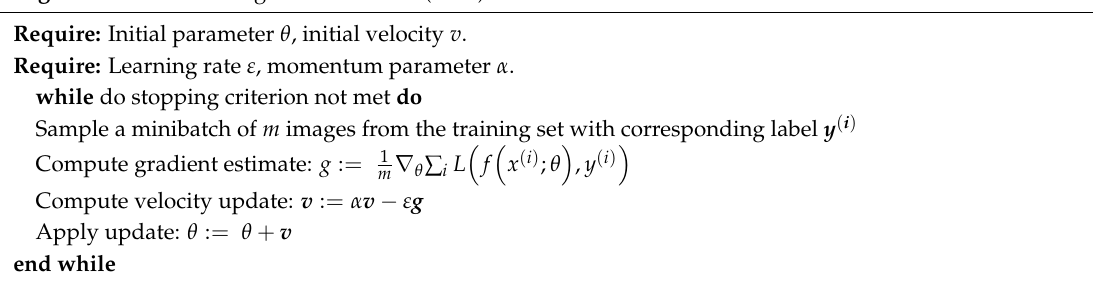
Algorithm 1. Stochastic gradient descent (SGD) with